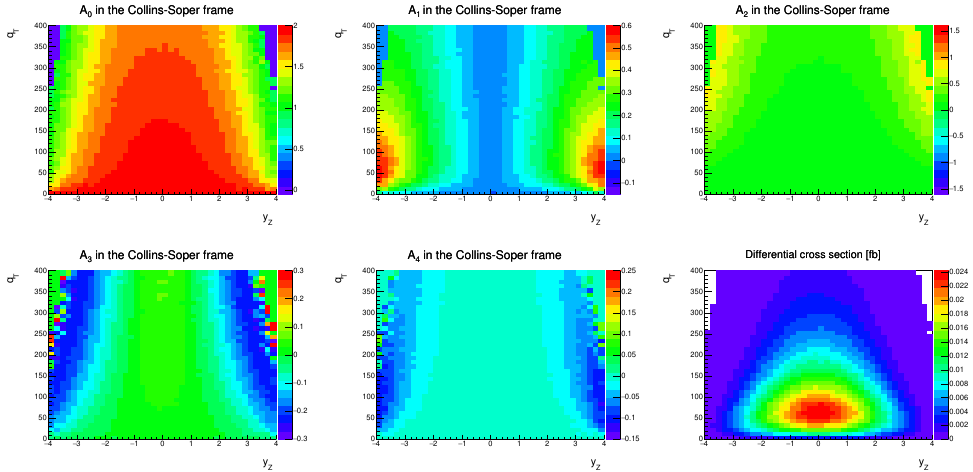
Figure 10 . Angular coe(cid:14)cients A 0 scenario S1 b .